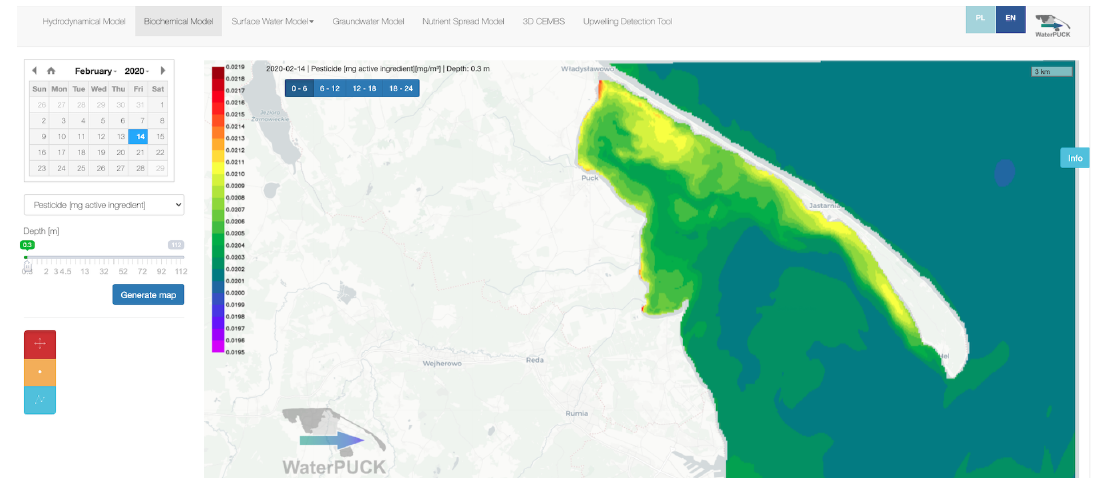
Figure 14. Concentration of the active ingredient of modelled pesticides.